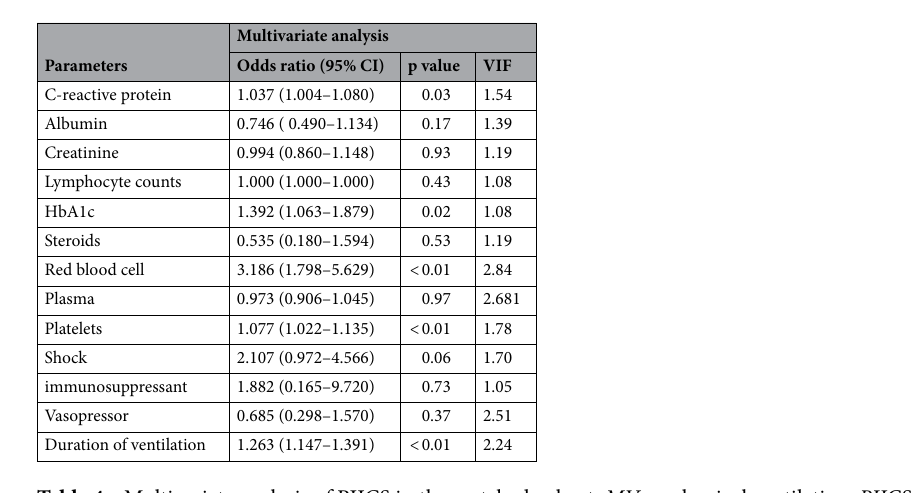
Table 4. Multivariate analysis of PIICS in the matched cohort. MV mechanical ventilation, PIICS persistent inflammation, immunosuppression, and catabolism syndrome, VIF variance inflation factor, CI confidence interval, HbA1c glycated